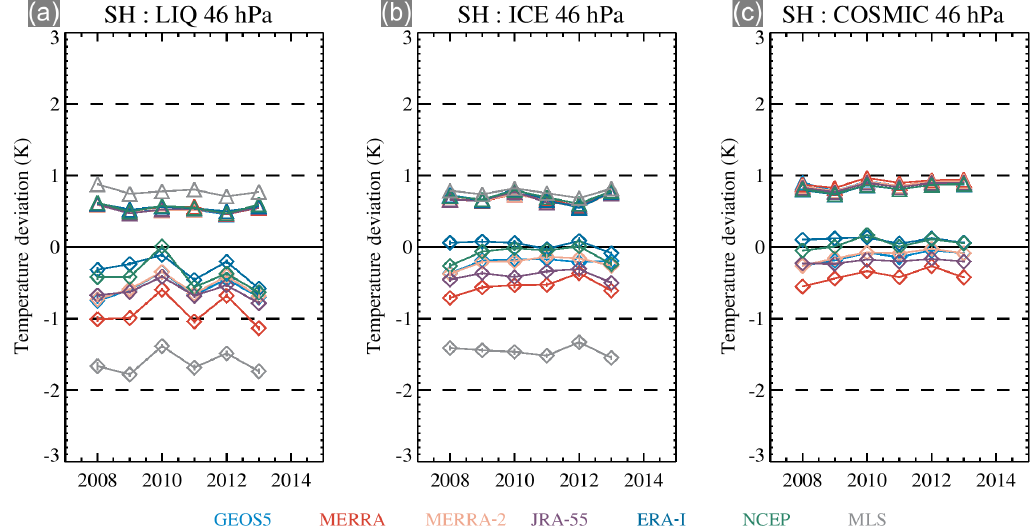
Figure 15. Median temperature deviations (diamonds) from T eq for (a) LIQ PSCs and from T ice for (b) ICE PSCs for the temperature distributions in each year (2008–2013) at 46hPa. The standard deviations of the temperature deviations are also shown (triangles). Lines for the different reanalyses, GEOS-5.9.1, and MLS are color coded (see legend). (c) The same as for panels (a, b) except for deviations with respect to COSMIC GPS